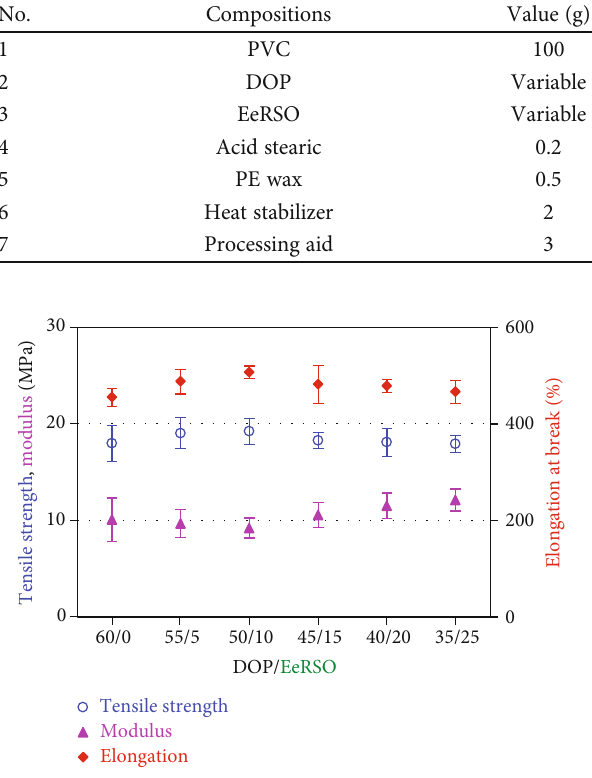
Figure 1: The e ff ect of EeRSO content on the mechanical properties of PVC.